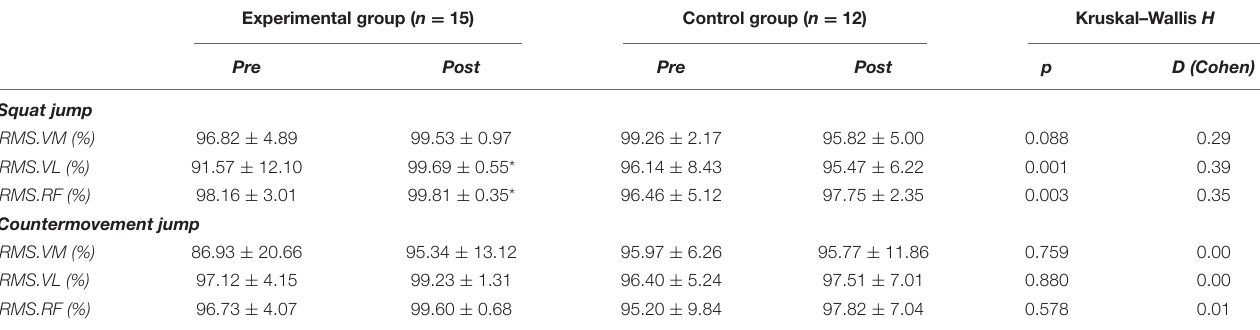
TABLE 8 | Comparison of root-means-squares of EMG voltages for squat jump and countermovement jump between experimental and control groups before (pre) and after (post) the 8-week trial. Experimental group ( n = 15)